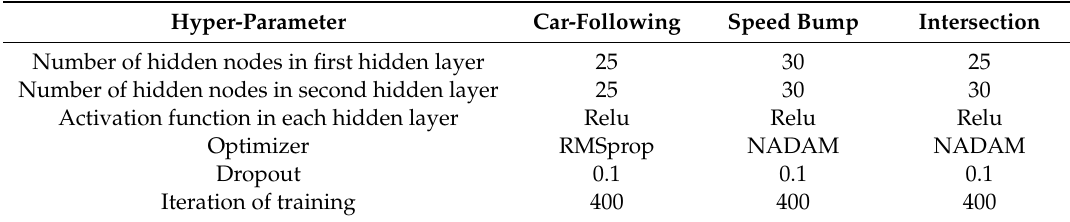
Table 4. Optimized hyper-parameter set in each deceleration condition. Hyper-Parameter Car-Following Speed